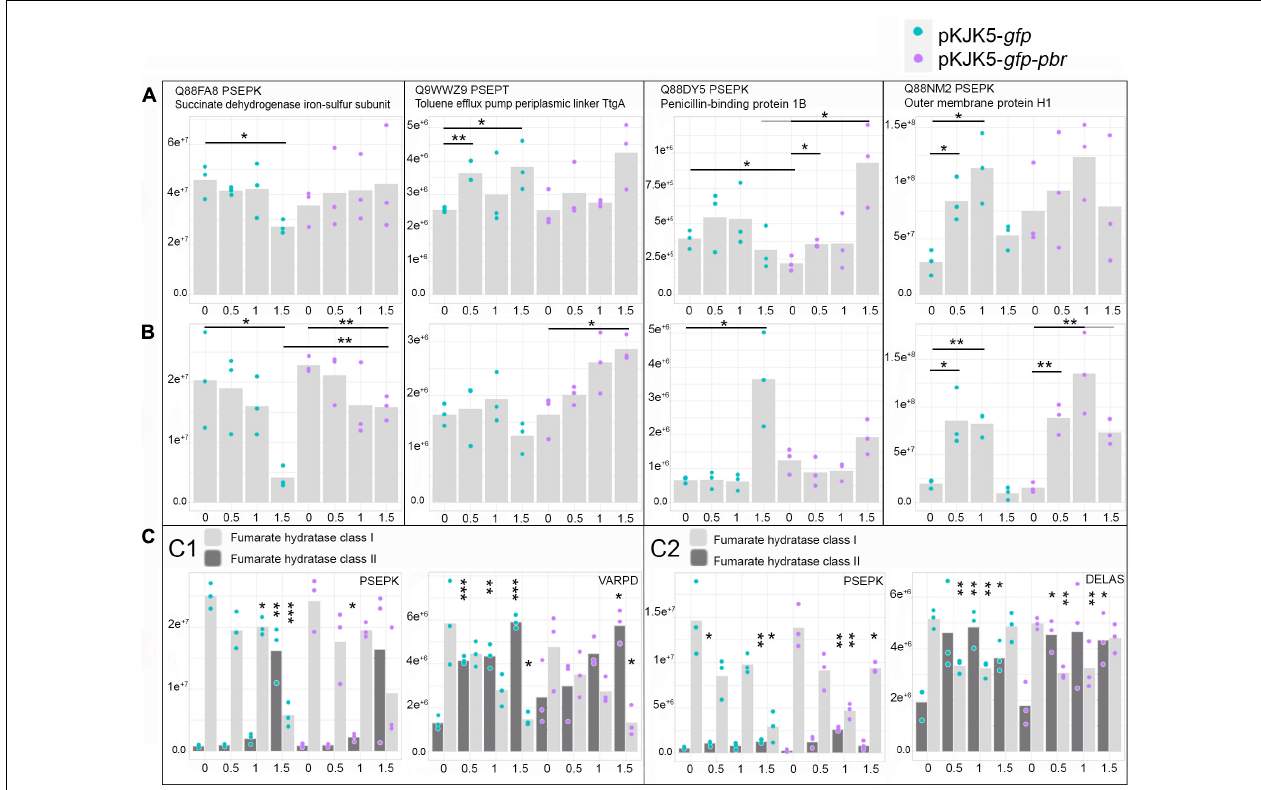
FIGURE 5 | Abundances ( ± SEM) of proteins of interest in the two-member community without the pbr TRABCD operon (blue) or including the pbr TRABCD operon (purple) depending on Pb(II) concentration (mM). Different panels represent the abundance of proteins identified as belonging to Pseudomonas putida KT2440 when cultivated with Variovorax paradoxus B4 (A) or with Delftia acidovorans SPH-1 (B) ; the abundance of fumarate hydratase enzymes in P. putida KT2440 (PSEPK) and V. paradoxus B4 (VARPD) when cultivated together (C1) and in P. putida KT2440 (PSEPK) and D. acidovorans SPH-1 (DELAS) when cultivated together (C2). The p -values were calculated from log-2-transformed abundances using a t -test ( n = 3). * p -value < 0.05; ** p -value < 0.01; *** p -value < 0.001. In (C) , the p -values were calculated between the different lead concentrations (Pb0.5, Pb1, or Pb1.5) and the control (Pb0) of the same co-culture.